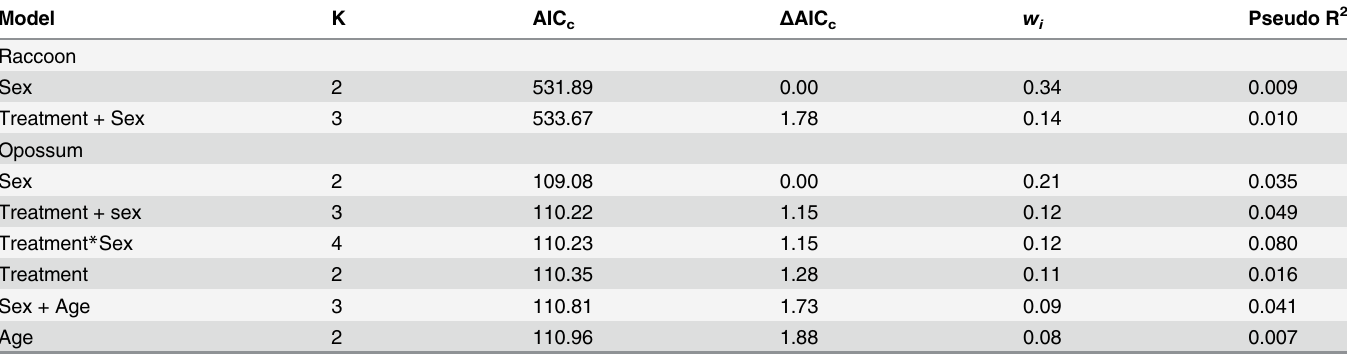
Table 2. Highest ranking logistic regression models ( Δ AIC c (cid:3) 2) of Rhodamine B uptake by raccoons and opossums on 8 study sites in the Upper Wabash River Basin, Indiana. Model